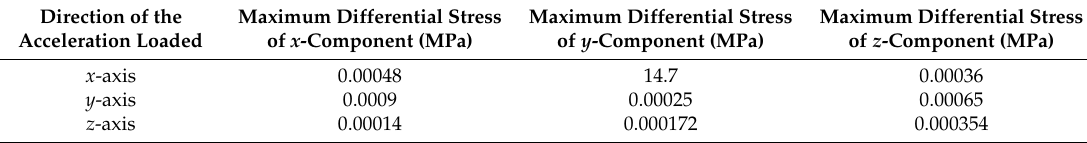
Table 2. The results under 100 g acceleration applied to the x -axis, y -axis and z -axis. Direction of the Acceleration Loaded